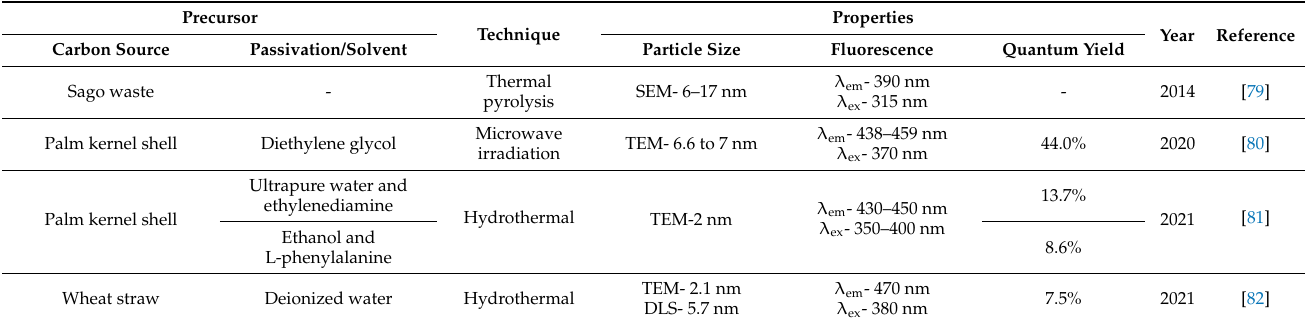
Table 5. Summary of the synthesis of CDs from crop